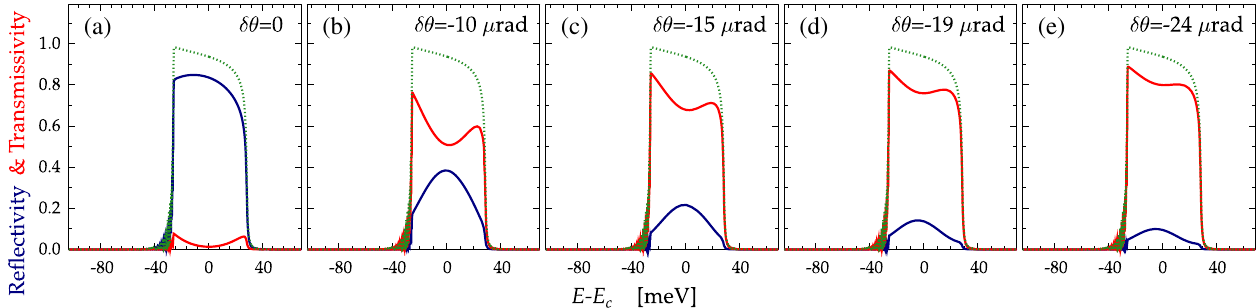
FIG. 8. Similar to Fig. 7, however the beam splitter shown in Fig. 3(b) is a diamond crystal with a fixed 28 - μ m thickness set in the (111) Bragg reflection at incidence angles θ ¼